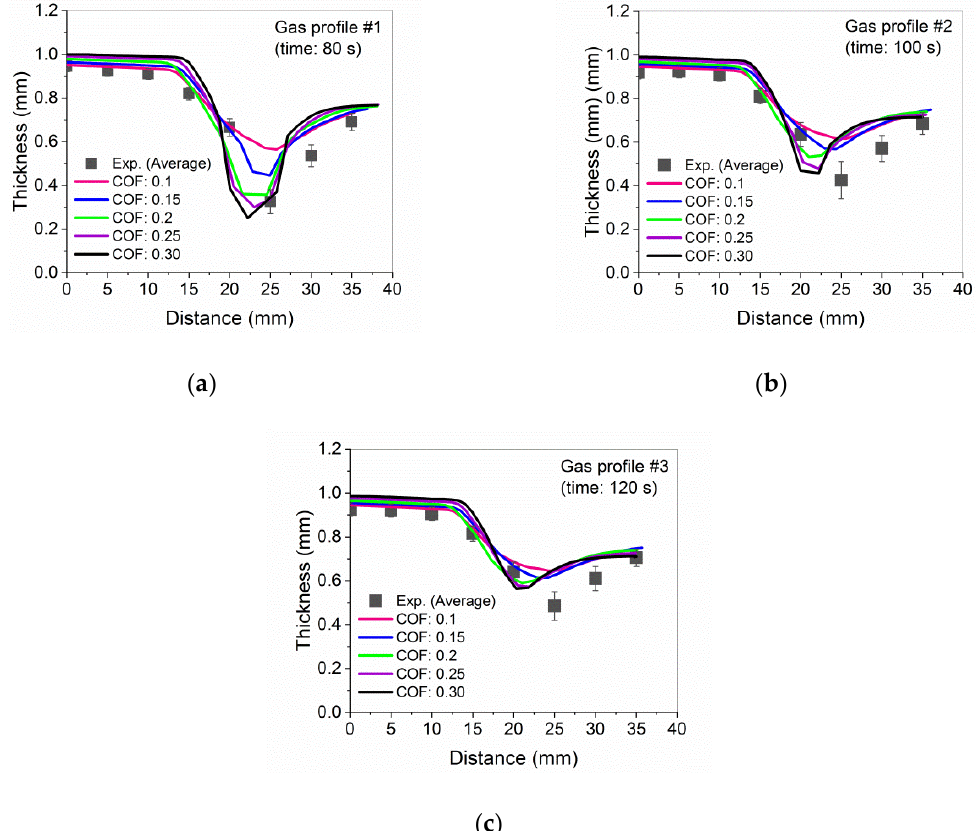
Figure 11. Thickness variation along the eight measuring points for; ( a ) gas pressure profile #1 ( t = 80 s); ( b ) gas pressure profile #2 ( t = 100 s); and ( c ) gas pressure profile #3 ( t = 120 s).